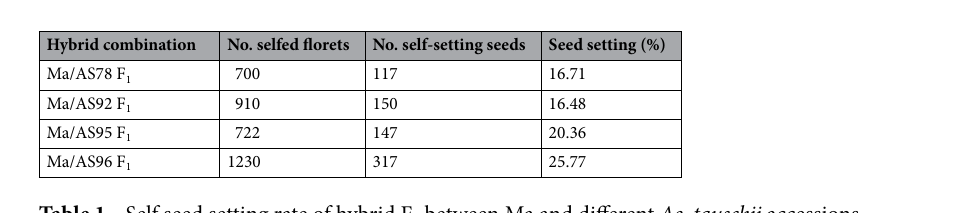
Table 1. Self seed setting rate of hybrid F 1 between Ma and different Ae. tauschii accessions.